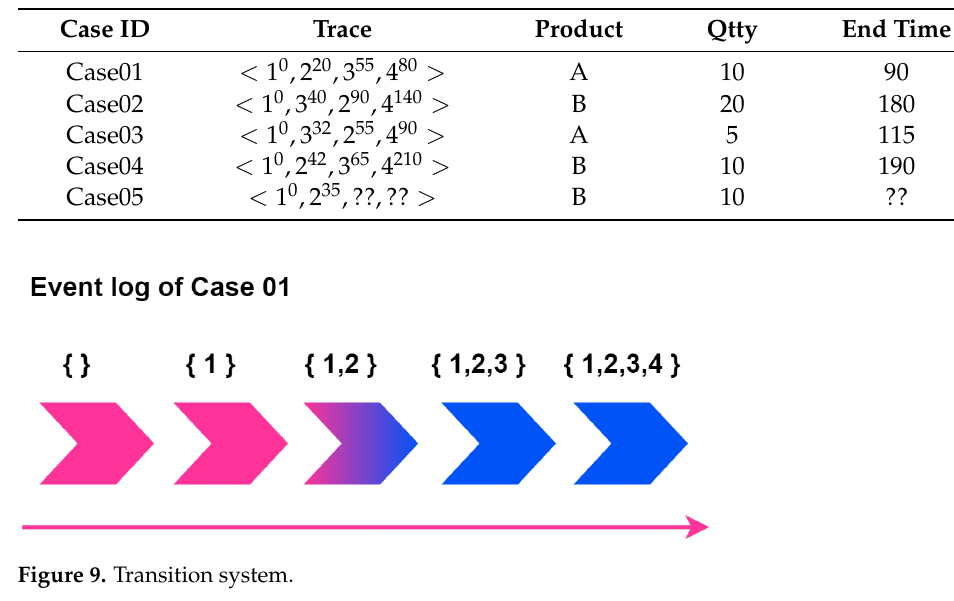
Table 2. Normalization of the event log.